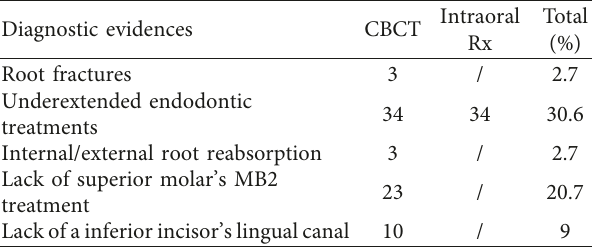
Table 1: Comparison of diagnostic evidences detection between CBCT and intraoral